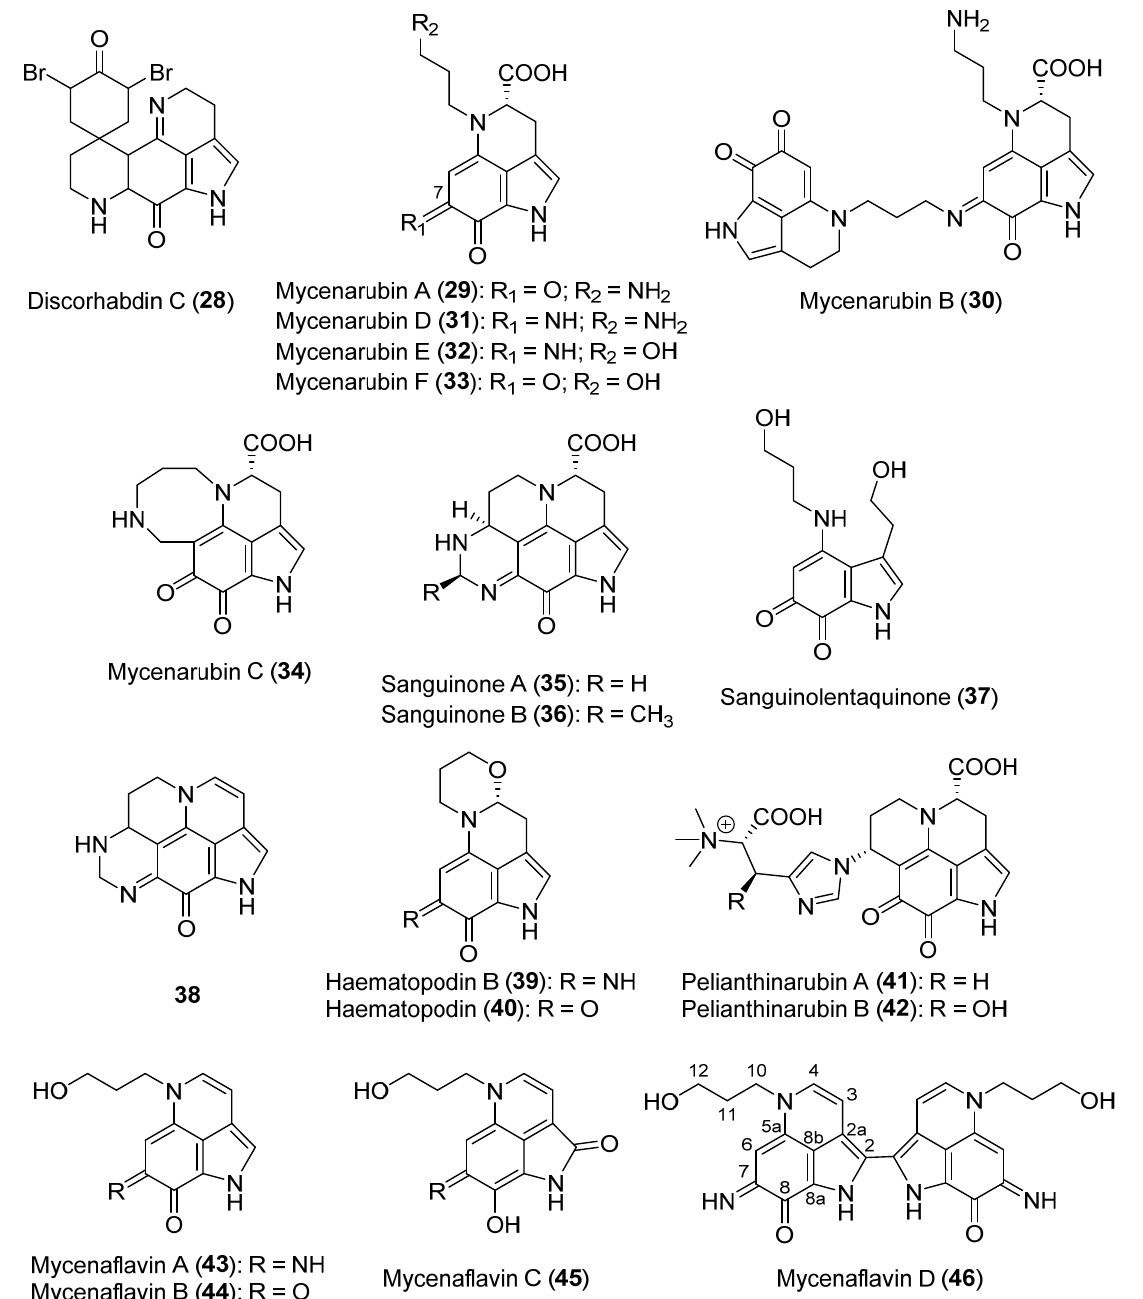
Figure 3. The structures of discorhabdin C ( 28 ) and the pyrroloquinoline alkaloids isolated from mushrooms ( 29 – 46 ).